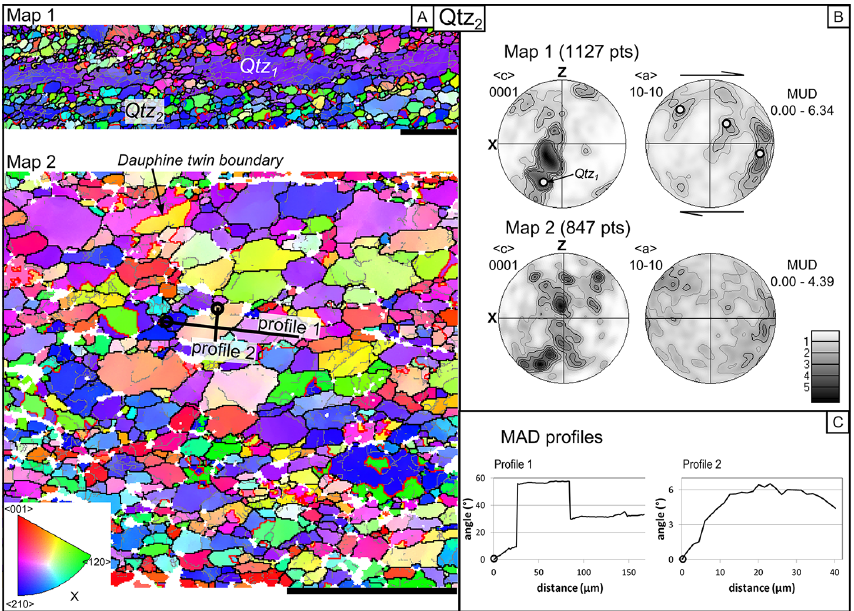
Figure 8. (a) GB (grain boundary) + IPF (inverse pole figure) map of Qtz 2 microstructures (acquisition locations marked in Figs. 5a, 6b), scale bars 200µm. (b) Pole figures of the crystallographic orientation data for map 1 and map 2, plotted as one point per grain using equal- area projection and the upper hemisphere. The white dot in the pole figure for map 1 marks the orientation of the Qtz 1 grain, which occurs at the central part of the Qtz 2 domain. (c) Misorientation profiles across two selected regions in map 2, where the profiles are marked by black lines and the circle represents starting